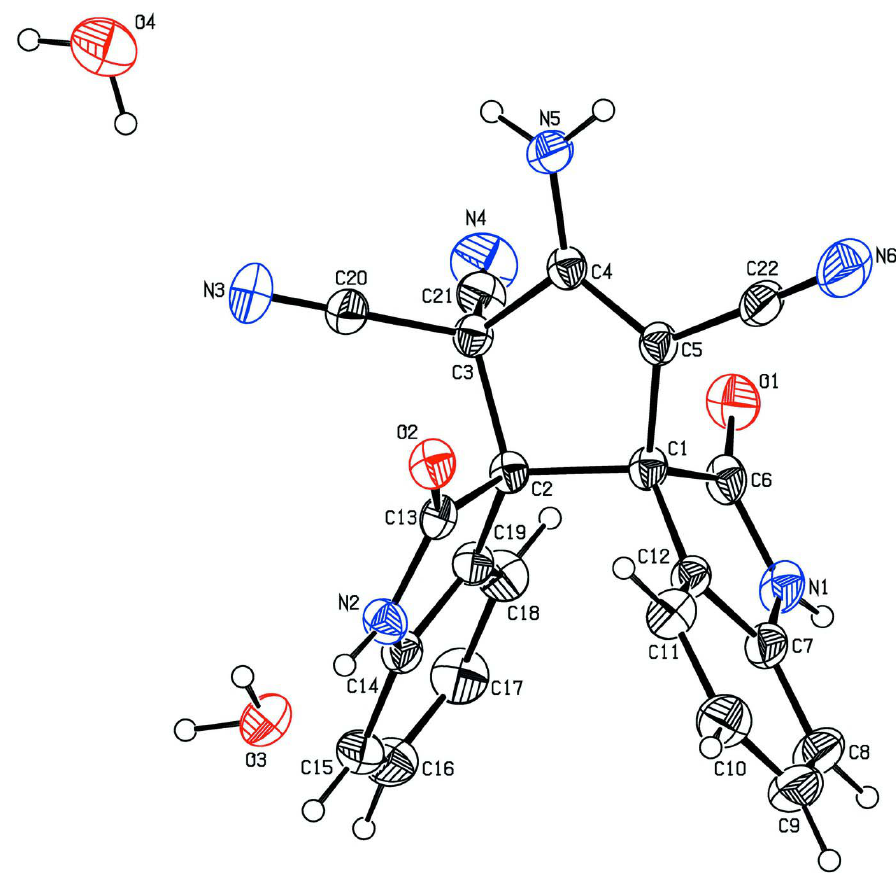
Figure 1 The molecular structure of title compound, showing 30% probability displacement ellipsoids for non-H